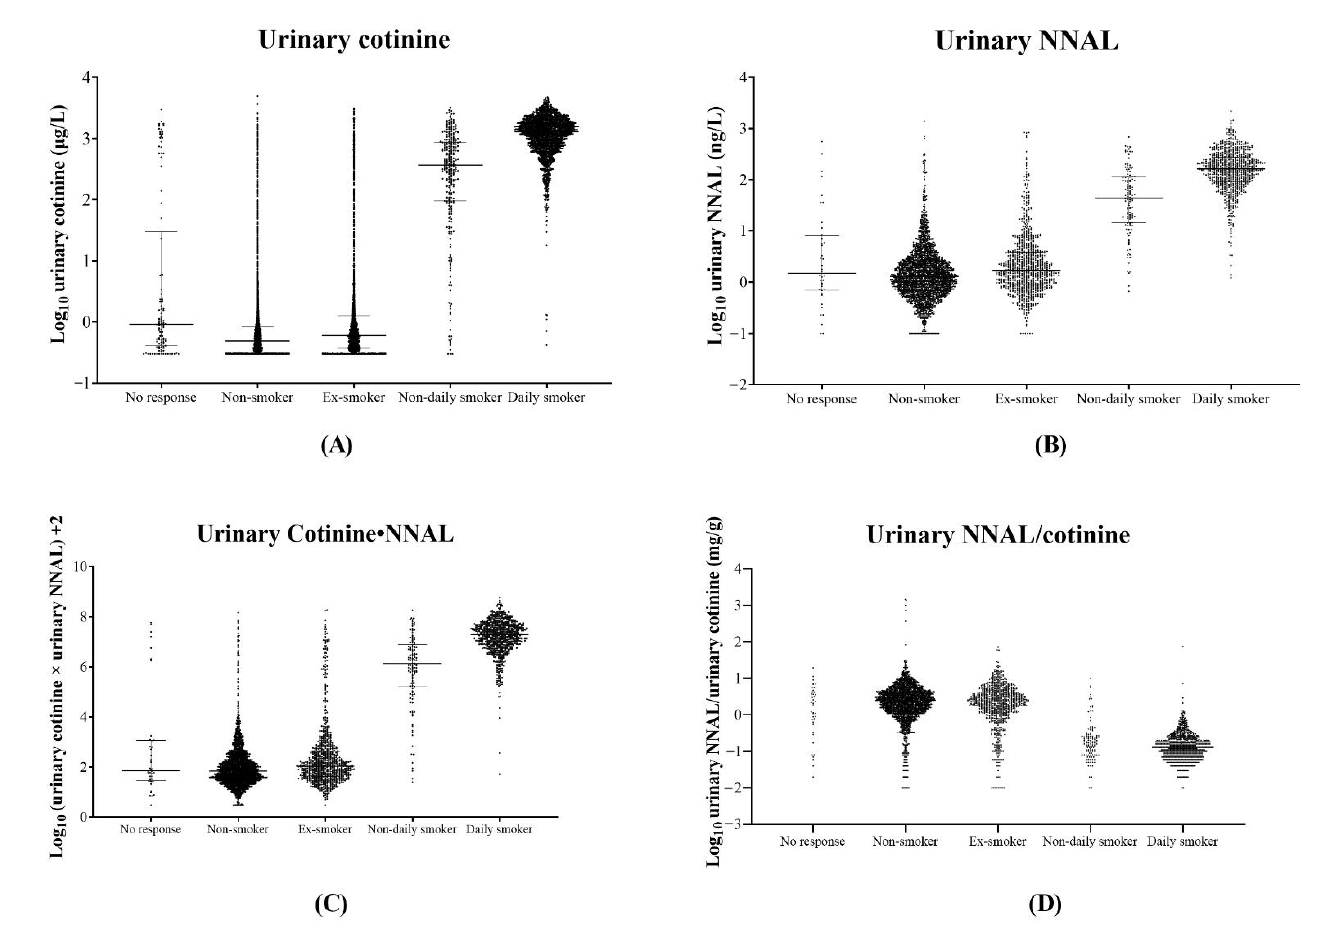
Figure 4. The scatter plots of four urinary biomarkers, according to smoking statuses. Urinary cotinine ( A ), NNAL ( B ), cotinine · NNAL ( C ), and NNAL/cotinine ( D ). The horizontal solid lines represent the median values of each biomarker. NNAL 4-(methylnitrosamino)-1-(3-pyridyl)-1-butanol.